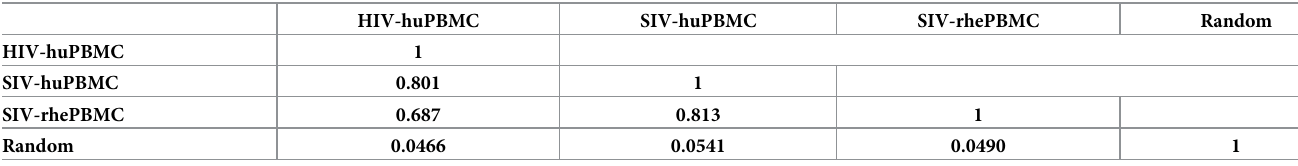
Table 3. Correlation of the distribution of HIV and SIV integration sites (whole genome).